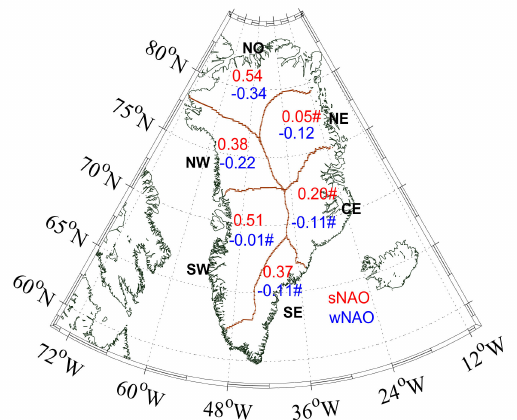
Figure 7. Correlations between the NAO index and mass changes for the six drainage basins in Greenland. Red values represent the correlation between the summertime NAO (sNAO) index and the summertime mass changes in each basin, and blue values represent the correlation between the wintertime NAO (wNAO) index and the wintertime mass changes from GRACE. The correlation values with # represent the significant value p >